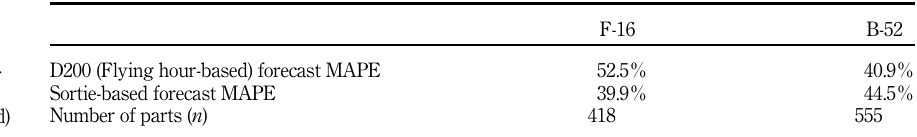
Table 1. 2018 forecast error comparison (D200 versus